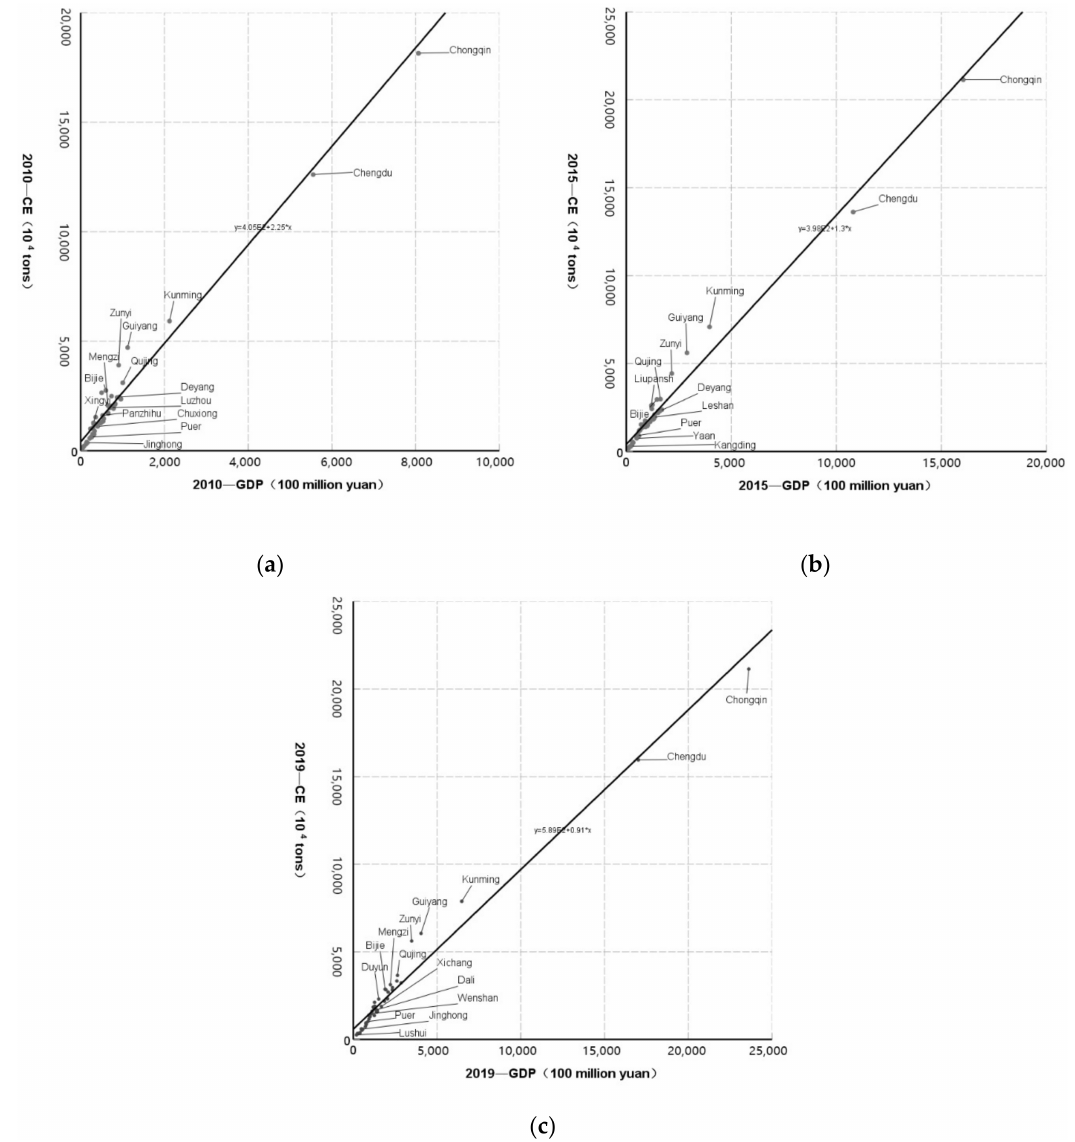
Figure 8. ( a ) Carbon emission efficiency of cities in southwest China (2010). ( b ) Carbon emission efficiency of cities in southwest China (2015). ( c ) Carbon emission efficiency of cities in southwest China (2019).